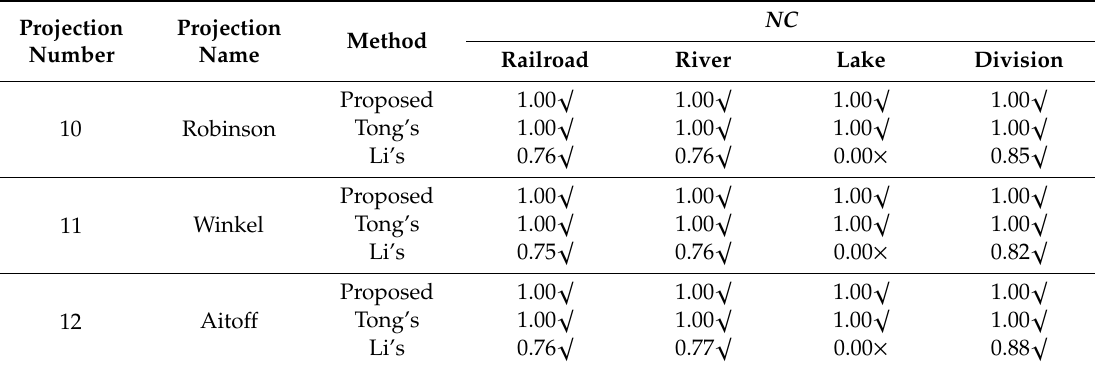
Table 8. The results after compromise projection